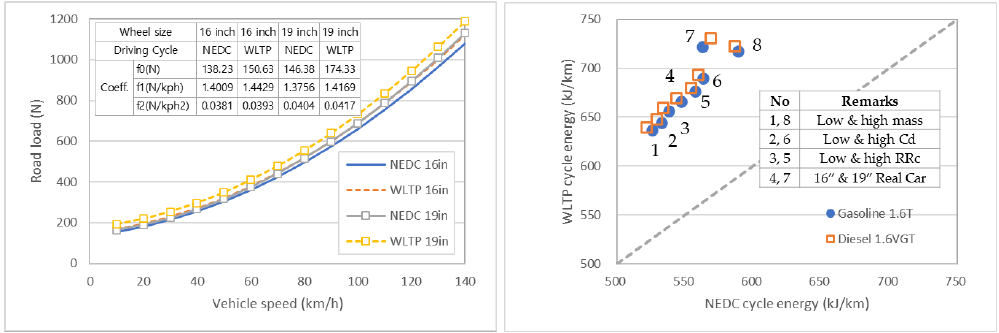
Figure 6. Road load curve and driving energy per distance according to the test cycle .